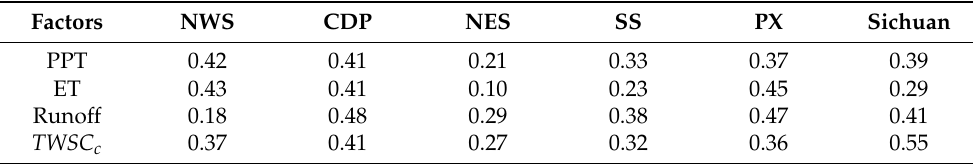
Table 6. The correlation coefficients between the different factors from climate change and TWSC in Sichuan and its five